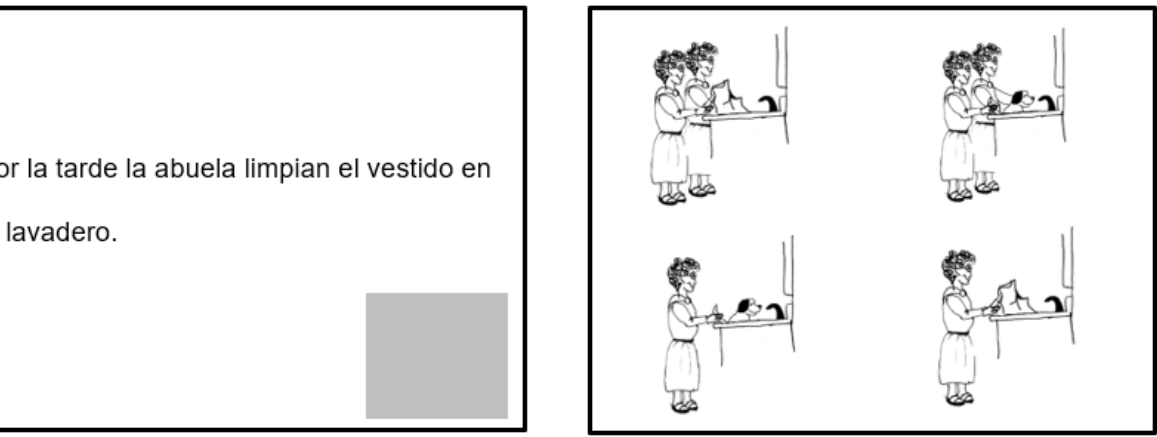
Figure 1. Sample trial of the eye-tracking